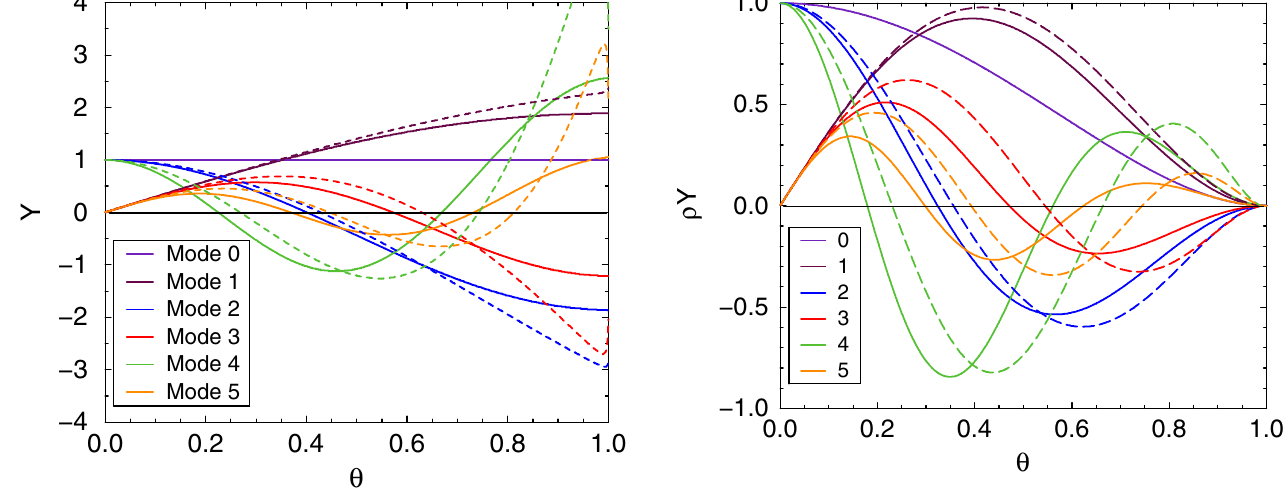
FIG. 2. (Color) Eigenfunctions of the parabolic bunch vs azi- muth. Solid lines: (cid:7) ¼ 0 : 05 ; dashed ones: (cid:7) ¼ 1 .